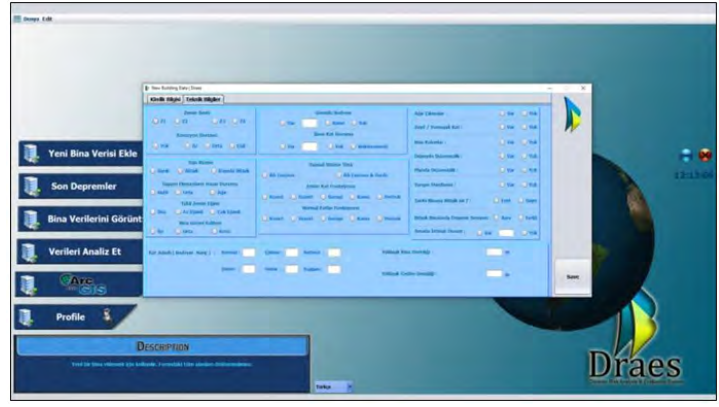
Figure 8. YeniBina Verisi – Teknik